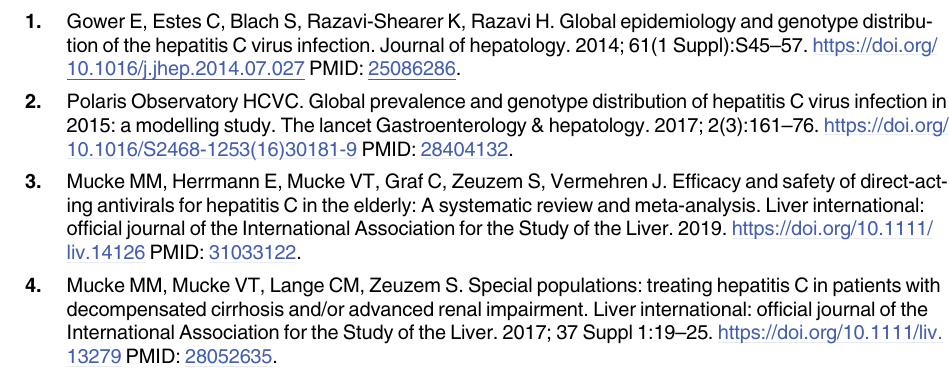
S5 Table. Comparison of cobas HCV and CAP/CTM using clinical cutoffs: � LLOQ vs. < LLOQ and detectable HCV RNA vs. TND week 12. S6 Table. Comparison of cobas HCV and CAP/CTM using clinical cutoffs: � LLOQ vs. < LLOQ and detectable HCV RNA vs. TND week 24. S7 Table. Comparison of cobas HCV and CAP/CTM using clinical cutoffs: � LLOQ vs. < LLOQ and detectable HCV RNA vs. TND 12 weeks after end of